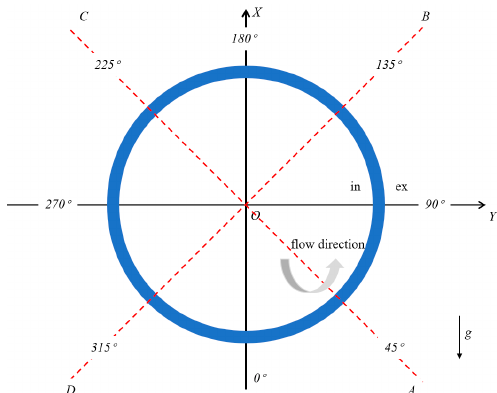
Figure 8. Profile of CT cross-sections.